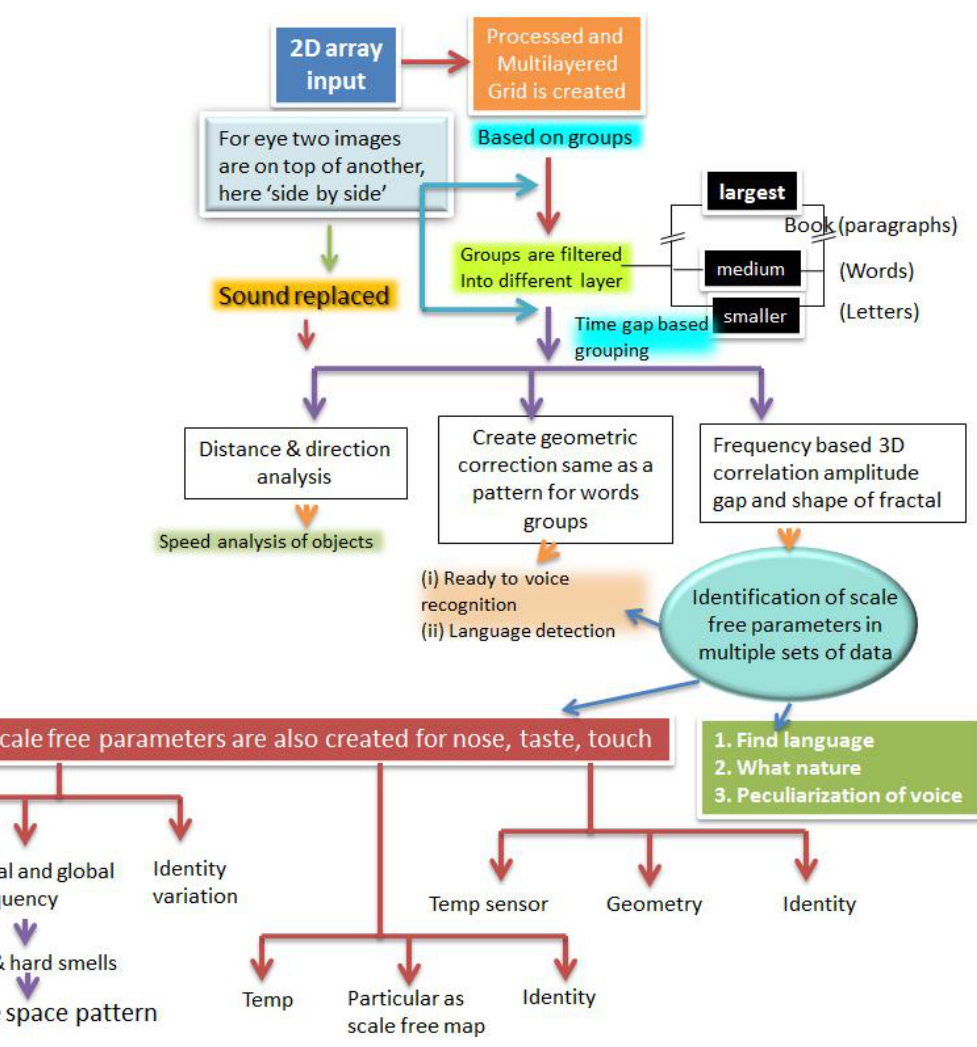
Figure 19. A diagram how actually the non-visual (taste, smell, touch, hear) sensors would operate under the new resonance chain